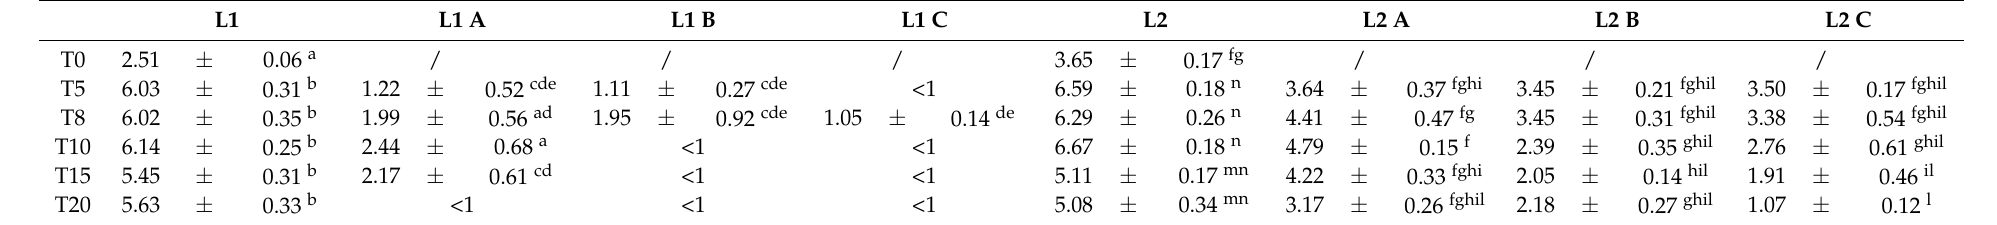
Table 1. The behavior of E. coli (k88, k99) in mozzarella cheese (L1: 2 Log CFU/mL and L2: 4 Log CFU/mL) in presence of CDH (A: 100 LOX-U/100L, B: 150 LOX-U/100L, C: 200 LOX-U/100L) during refrigerated shelf life (data are reported as the mean values ± standard deviation of Log CFU/g). The differences in microbial concentration observed over time were analyzed within the samples inoculated with the same initial concentration. Means with the same letter are not significantly different. L1 A